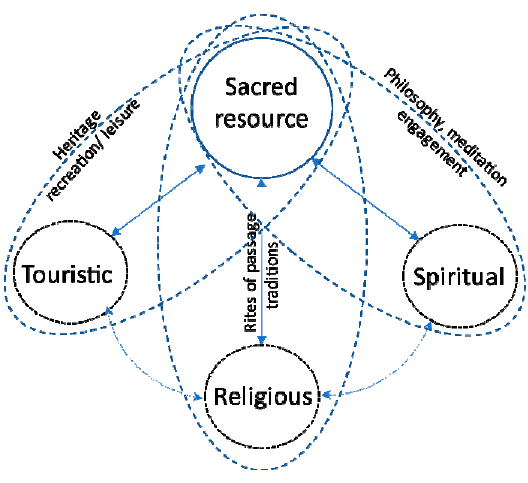
Figure 1. The ecosystem of religious tourism.